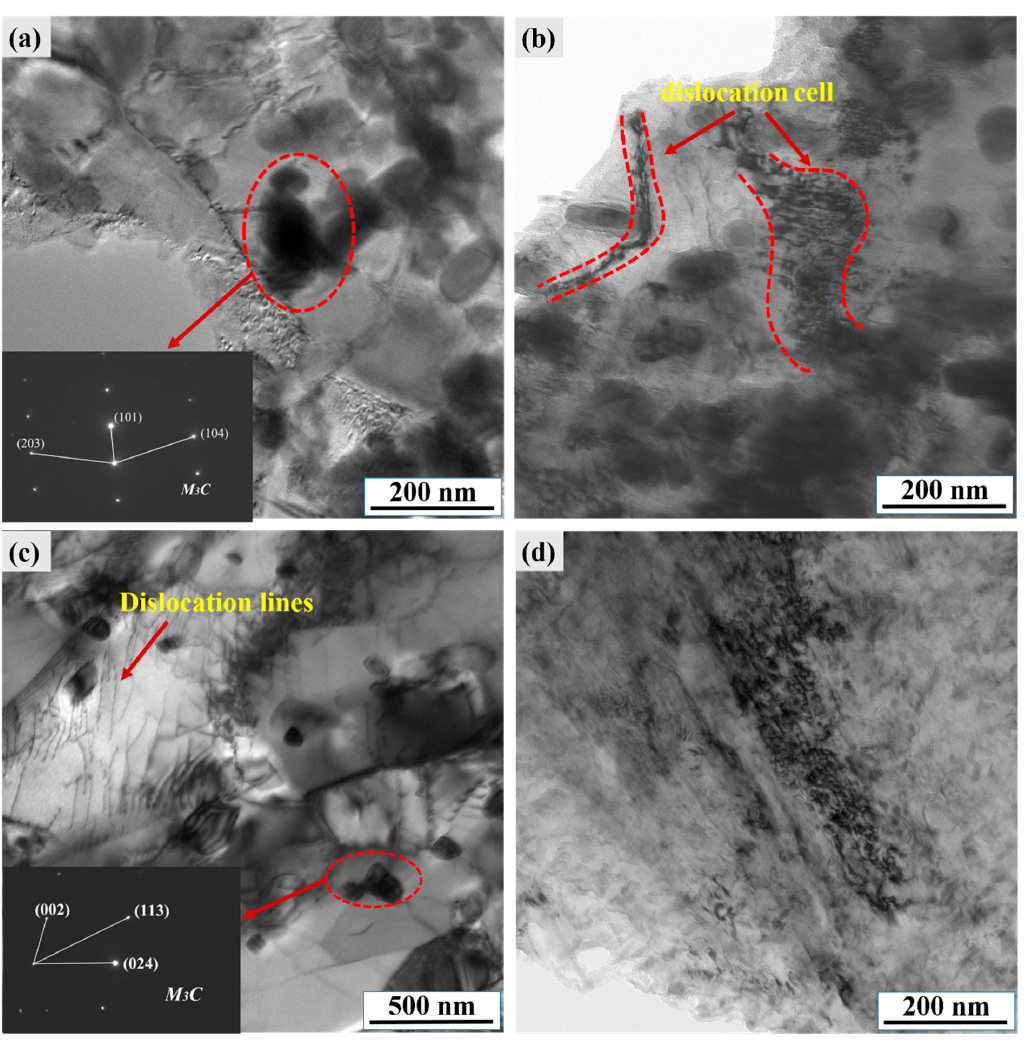
Metals 2023 , 13 , x FOR PEER REVIEW